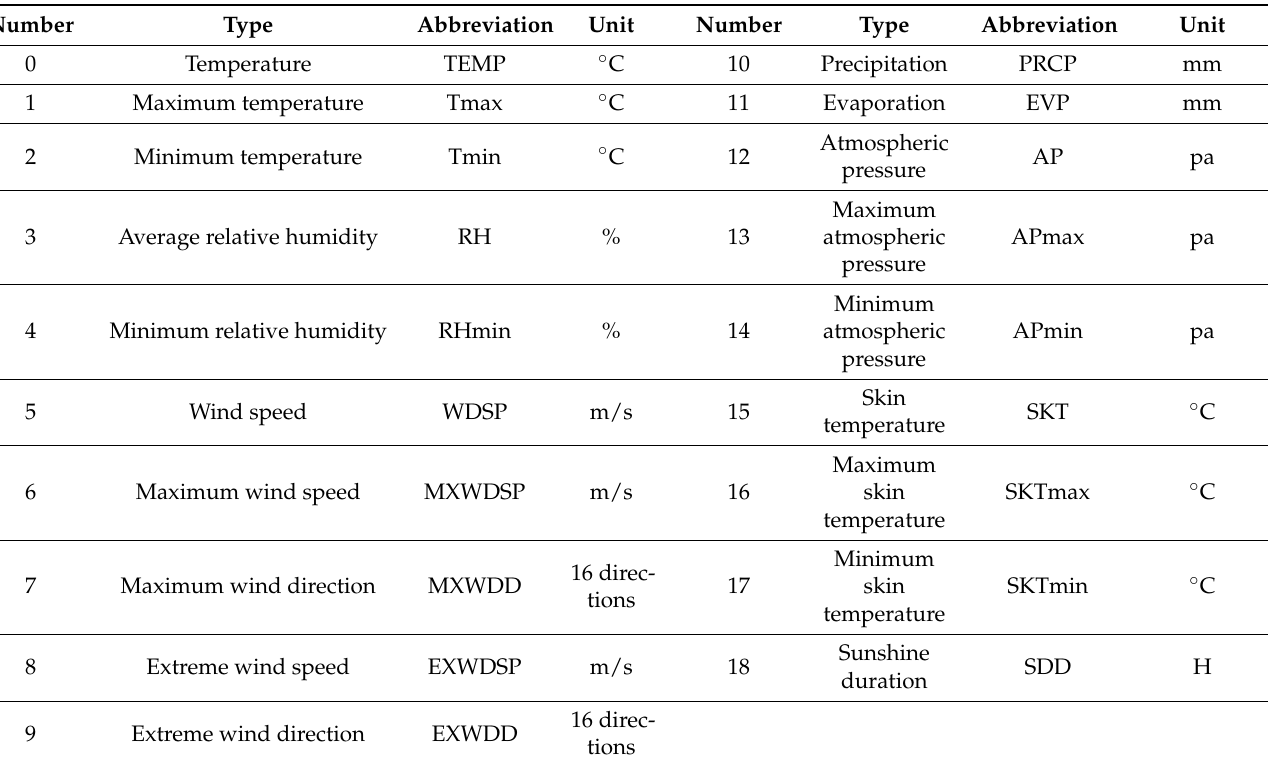
Table 2. Types and units of meteorological factors.